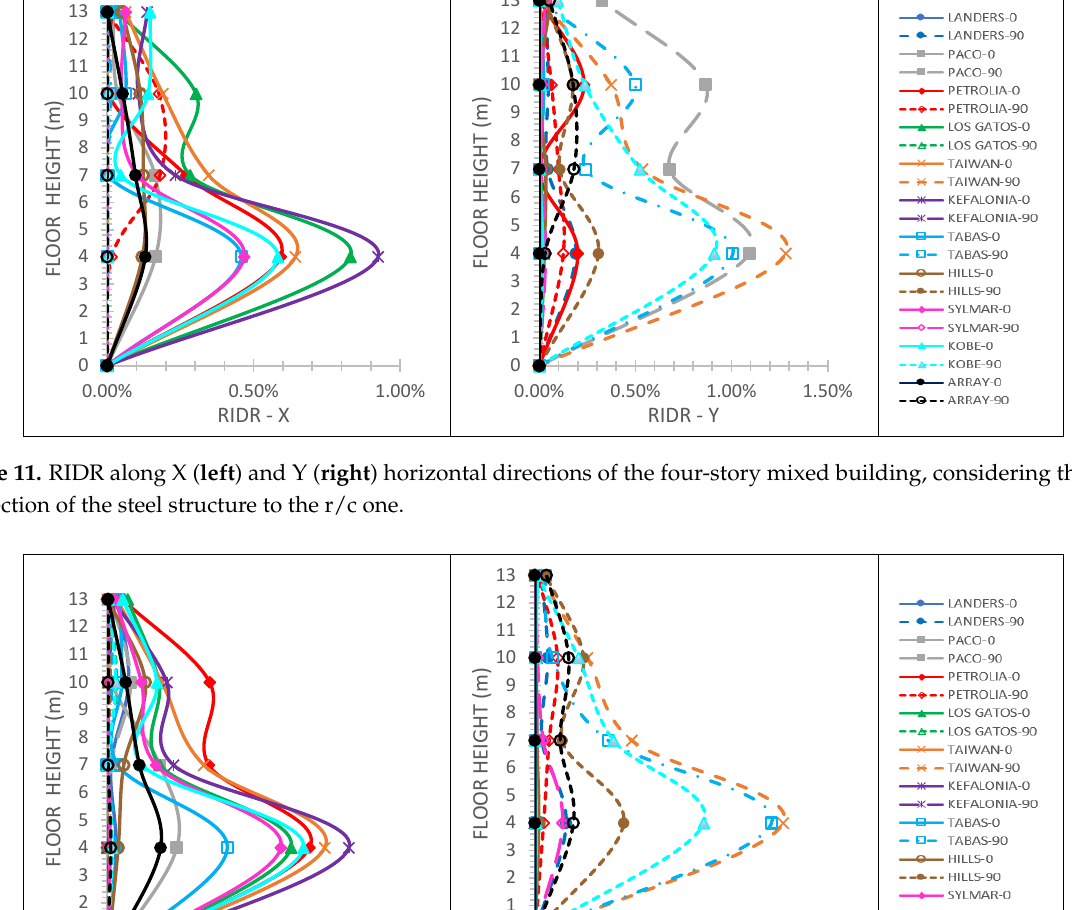
fixed-pinned connection of the steel structure to the r/c one.